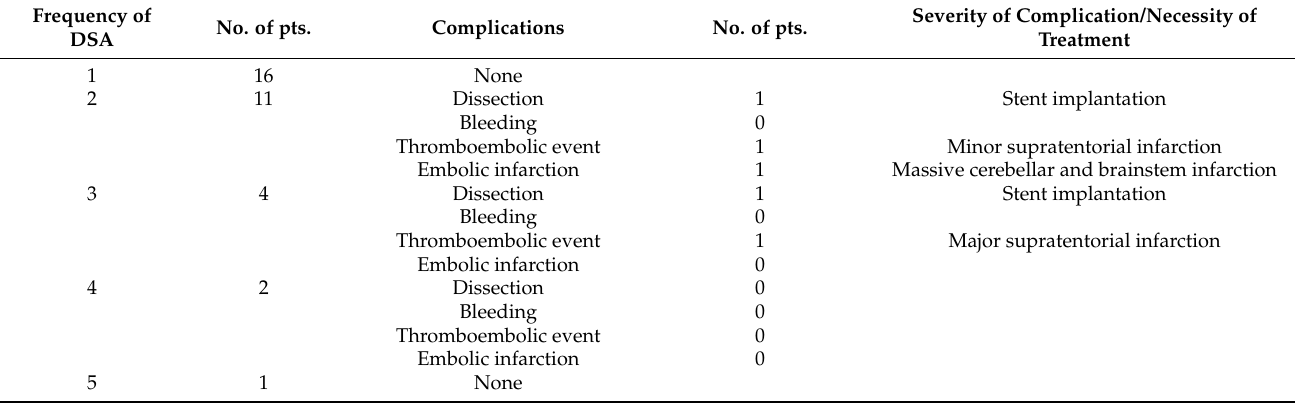
Table 3. Complications of invasive endovascular